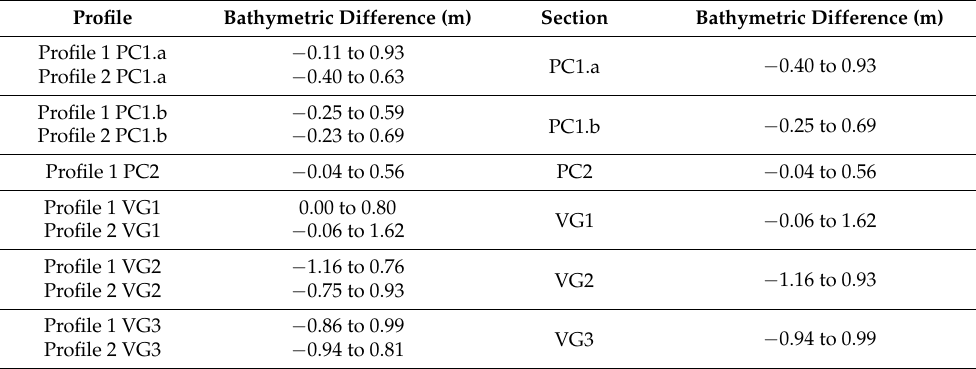
Table 5. Maximum and minimum values of differential bathymetry in each section.